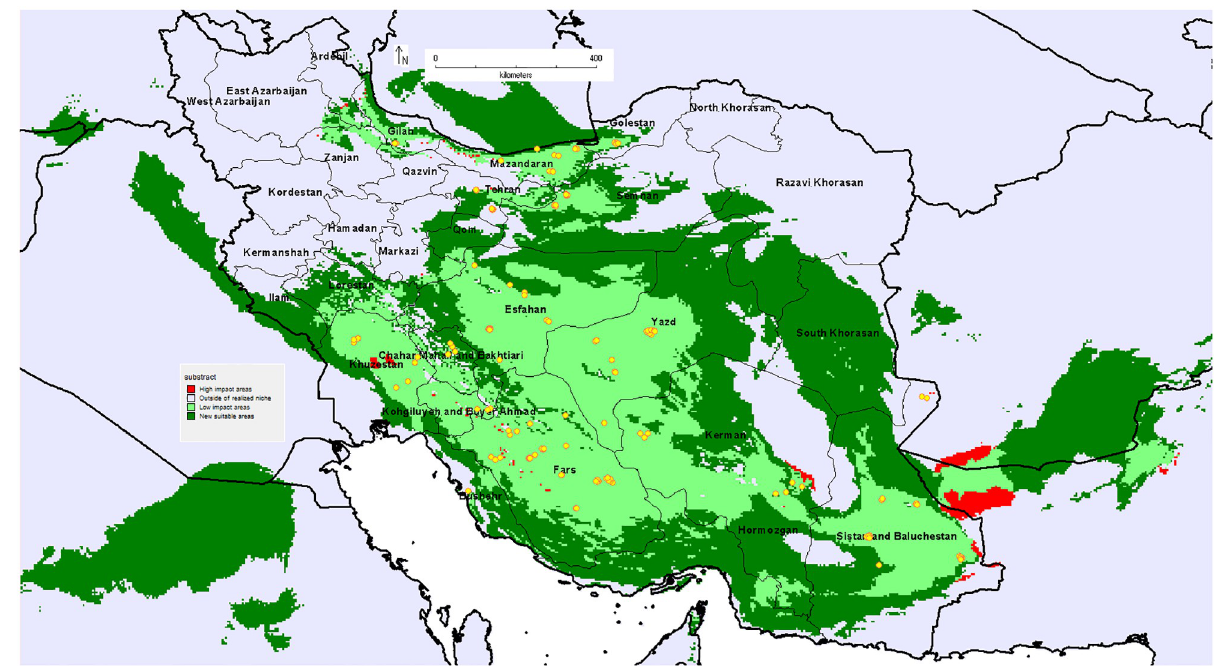
Fig 14. Future potential spatial distribution of pomegranate in Iran under the CCM3 climate model.